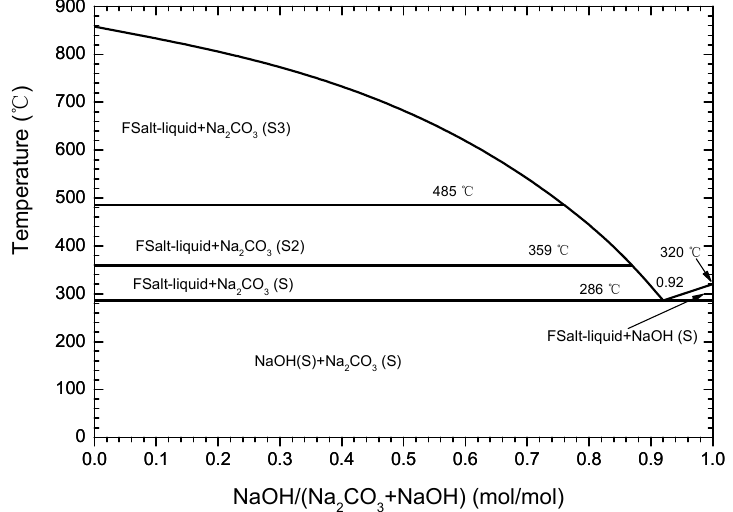
Figure 9. Phase diagram of NaOH and Na 2 CO 3 mixtures.